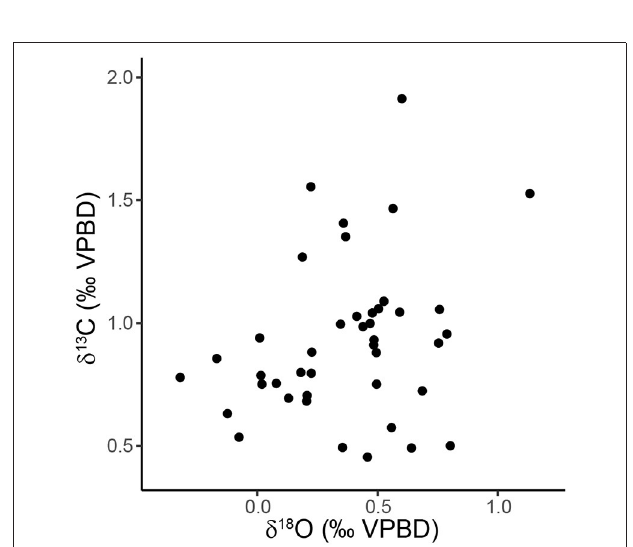
FIGURE 6 | Scatter plot showing the relationship between δ 18 O and δ 13 C of H. inflatus shells from the sediment trap samples ( p = 0.074, R 2 =